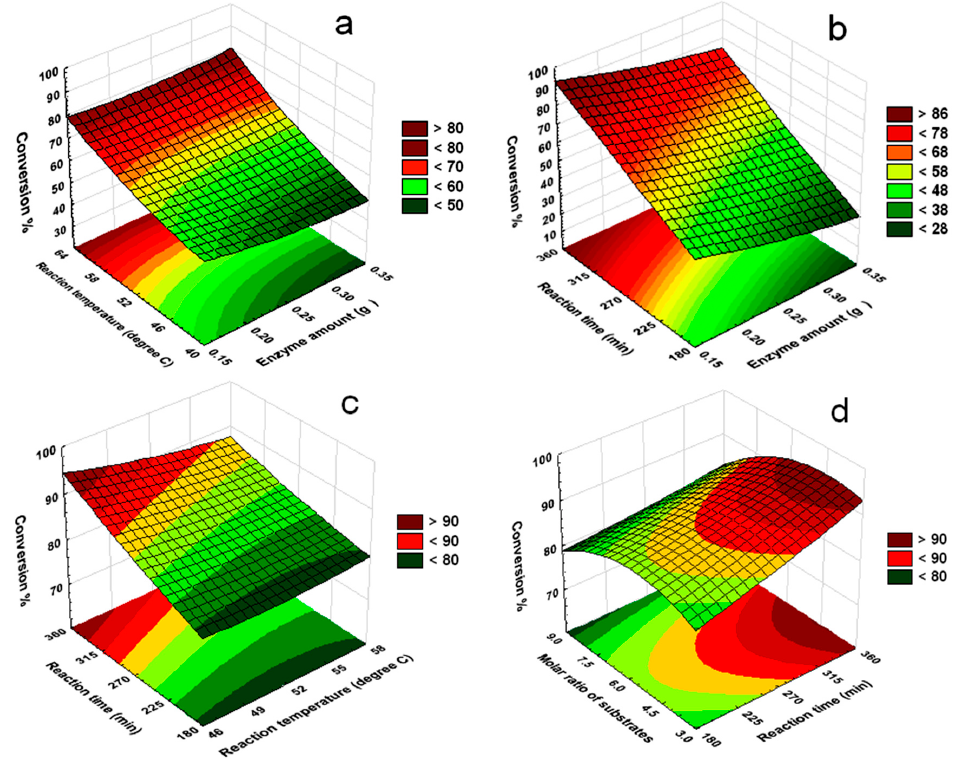
Figure 3. Response surface plots: ( a ) reaction temperature (°C) versus enzyme amount (g); ( b ) reaction time (min) versus enzyme amount (g); ( c ) reaction time (min) versus reaction temperature (°C); ( d ) reaction time (min) versus molar ratio of substrates (AzA:LA) (mole) on the percentage conversion as a response.